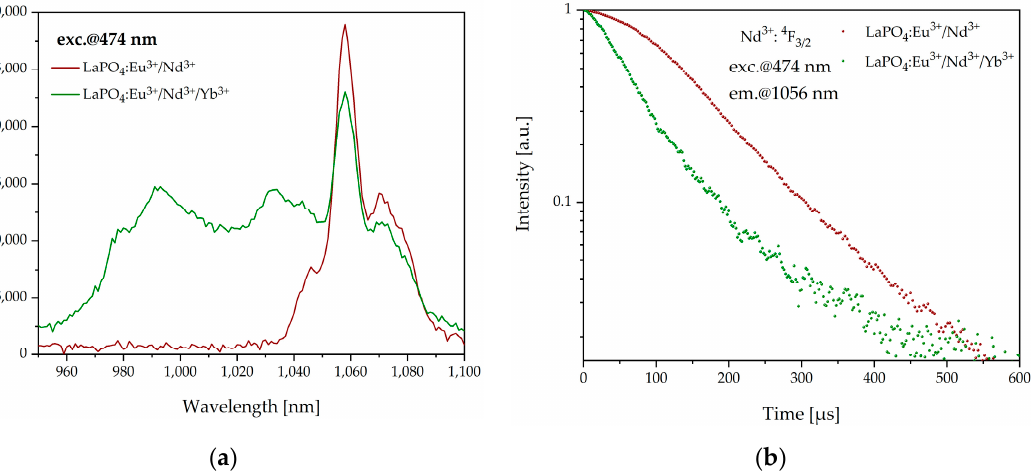
Figure 8. Luminescence spectra of LaPO 4 :Eu 3+ /Nd 3+ , and LaPO 4 :Eu 3+ /Nd 3+ /Yb 3+ excited at 474 nm ( a ) and luminescence decay curves from Nd 3+ : 4 F 3/2 ( λ exc = 474 nm) of LaPO 4 :Eu 3+ /Nd 3+ and LaPO 4 :Eu 3+ /Nd 3+ /Yb 3+ samples ( b ).